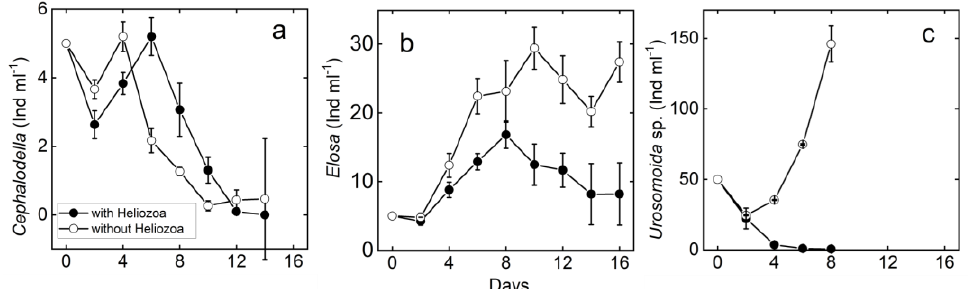
Figure 2. Time course of Heliozoan prey ( a , Cephalodella sp.; b Elosa woralli ; c , Urosomoida sp.) with and without A. sol . Mean ± standard error ( n = 3). Abundance of both rotiferan prey differed between treatments ( p = 0.03 for both) and also for ciliates ( p << 0.001). Note different y-axis scales.